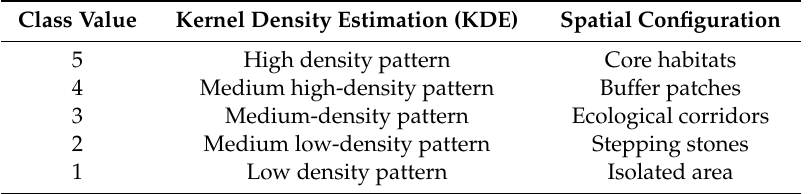
Table 5. Natural breaks classification of the kernel density estimation (KDE) patterns.